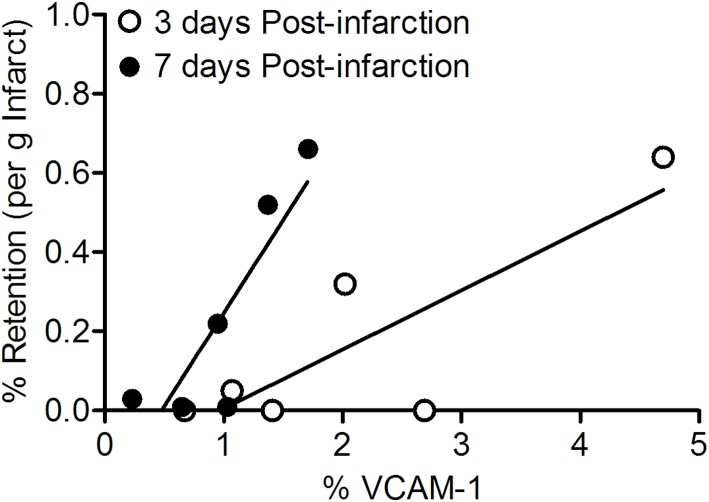
Regression analysis of VCAM-1 expression at 3 (○, r2 = 0.69, p = 0.03) and 7 days (●, r2 = 0.74, p = 0.04) days post-infarction vs. % of retained autologous bone marrow-derived cells per gram infarct.